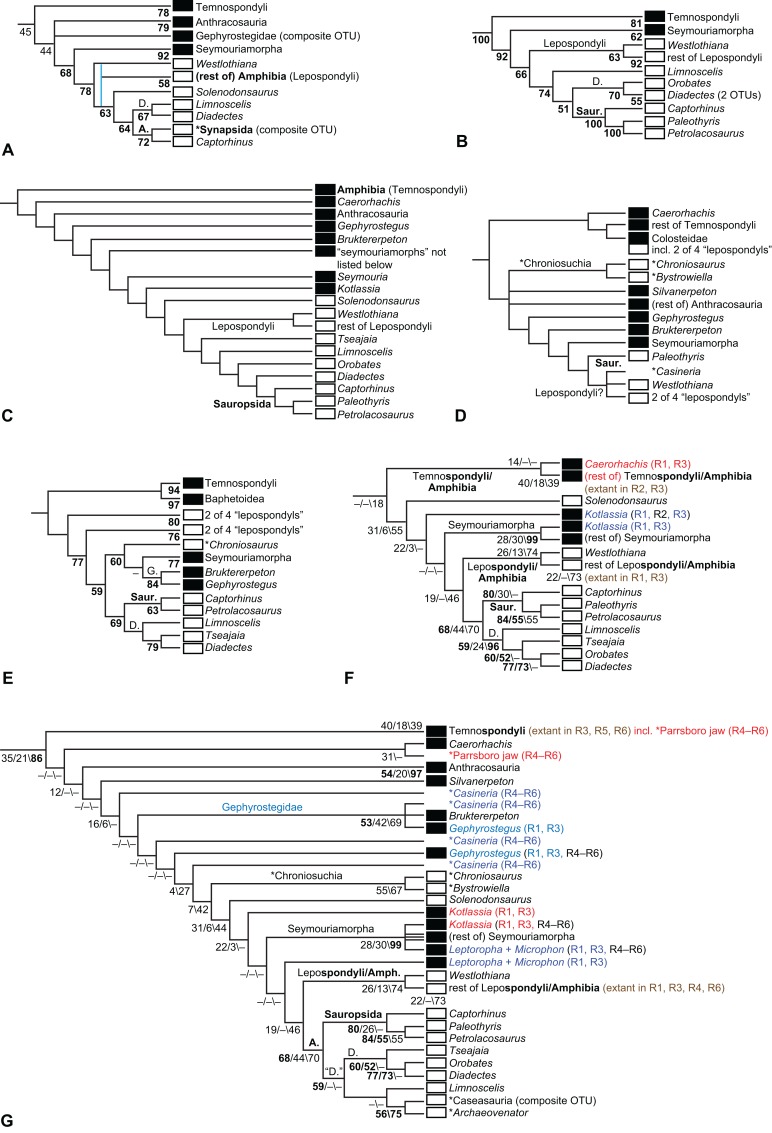
Amniote relationships and distribution of the intertemporal bone.Taxa not included in our analyses are omitted; those included in the expanded but not the original taxon sample are marked with an asterisk. Several named clades are collapsed. The matrices of (B), (C), (F) and (G) are ultimately based on that of Ruta, Coates & Quicke (2003), so they should not be considered fully independent of each other. Numbers are bootstrap percentages. Filled rectangles indicate presence of the intertemporal (state 0 of ch. 32—PAR 2/POSFRO 3/INTEMP 1/SUTEMP 1; see App. S1), empty rectangles its absence (any other state); the absence of a rectangle indicates missing data. A., Amniota; D., Diadectomorpha; Saur., Sauropsida. (A) Vallin & Laurin (2004). (B) Pawley (2006: chapter 6). (C) RC07; “rest of Lepospondyli” excludes the adelospondyls (see Figs. 1 and 24A), bootstrap values were not published. (D) Clack et al. (2012b; lacking *Bystrowiella) and Witzmann & Schoch (2017); all bootstrap percentages in this part of the tree are below 50 in both versions and were not published. (E) Klembara et al. (2014). Bootstrap percentages below 50 were not published, but note that a sister-group relationship of Chroniosaurus and Gephyrostegidae (G.) is supported by a bootstrap value of 53%. (F) Topologies from our Analysis R2 and some MPTs from R1 and R3, where Temnospondyli is closer to Amniota than Anthracosauria. Numbers are BPO/BPE\PP. (G) Topologies found in Analyses R4–R6 and the remaining MPTs from R1 and R3. Numbers below nodes are BPO/BPE\PP; the space for BPO is omitted where inapplicable. “D.” indicates Diadectomorpha for the original but not the extended taxon sample.